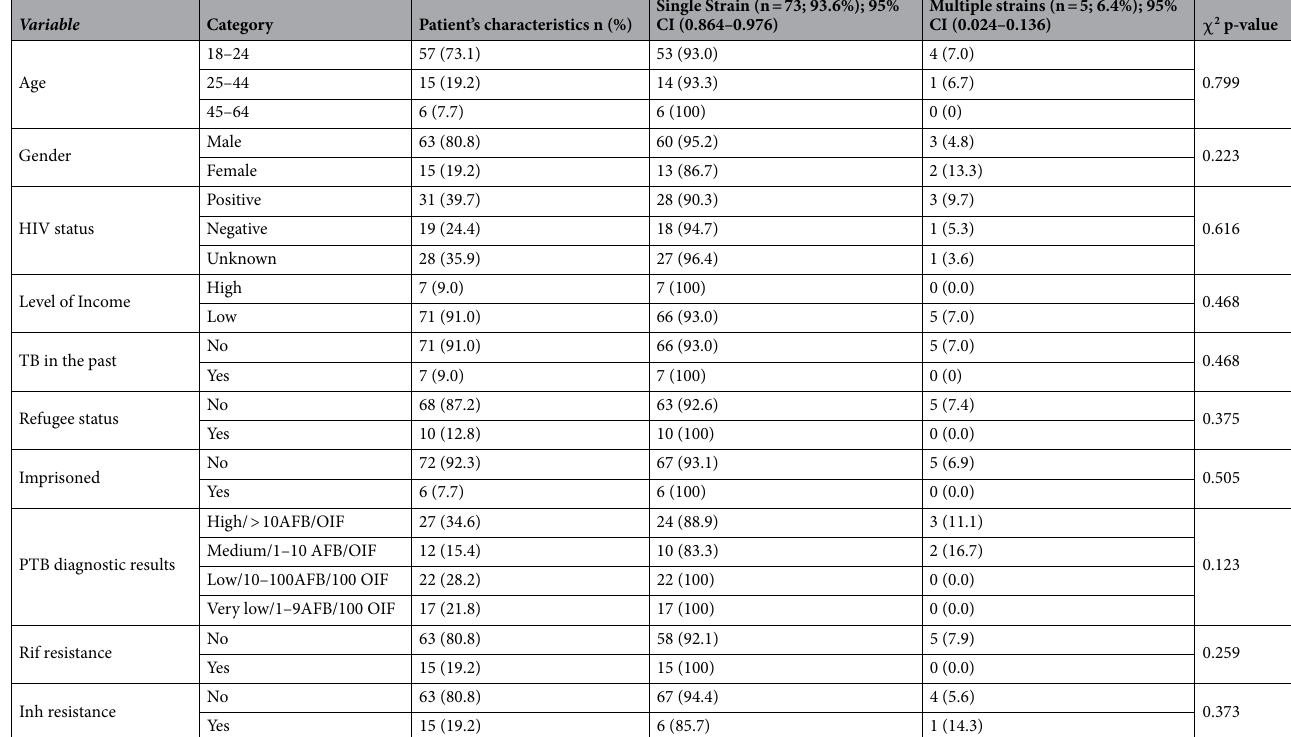
Table 1. Prevalence of M. tuberculosis multiple infections and comparison between patients with multiple versus single strain infections in Southwestern, Uganda. Statistical significance considered at p-value ≤ 0.05; OIF oil immersion field, Rif Rifampicin, Inh